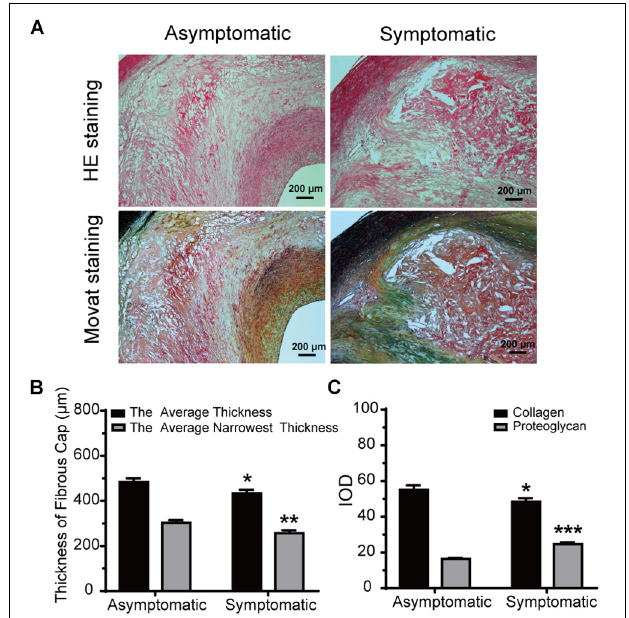
FIGURE 3 | Morphometric analysis data for HE and Movat staining. (A) Representative HE and Movat-stained sections of carotid atherosclerotic plaque in asymptomatic and symptomatic groups (bar = 200 µ m). (B) Average fibrous cap thickness and narrowest thickness of fibrous cap thickness in asymptomatic and symptomatic groups. (C) Quantification of collagen and proteoglycan in both groups. Error bars represent standard error of mean (SEM). * P < 0.05, ** P < 0.01, *** P < 0.001.